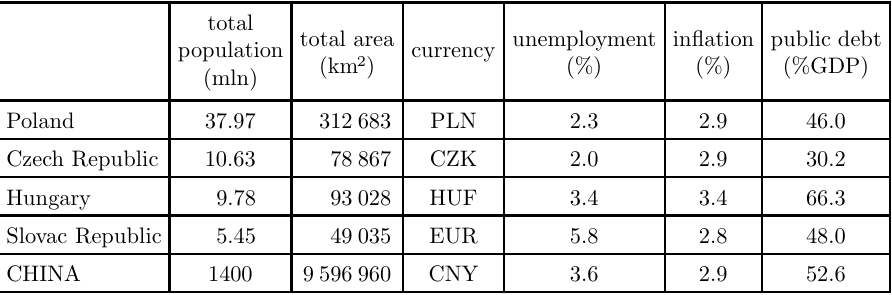
Main indicators of V4 and China, 2019 total total area unemployment inflation public debt population currency (km 2 ) (%) (%GDP)